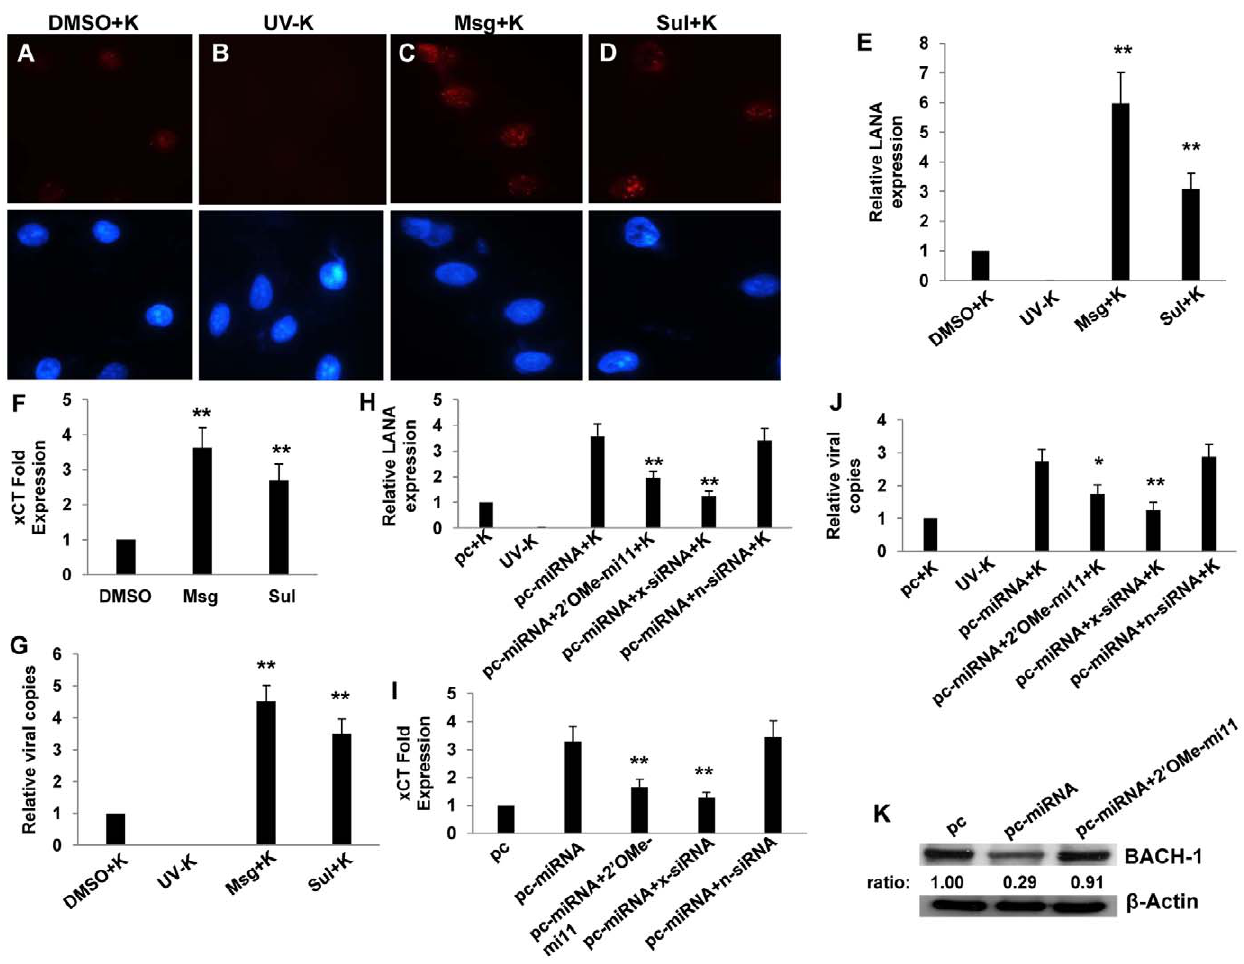
Figure 5. miR-K12-11 suppresses BACH-1 expression and increases endothelial cell susceptibility to KSHV through upregulation of xCT. ( A–G ) HUVEC were incubated with vehicle control (DMSO), Msg, or Sul for 12 h followed by purified KSHV (K) using an MOI , 0.5–1. 16 h later, LANA IFA were performed as previously described. (A–D) Representative images from one of three independent experiments are shown. ( H–K ) HUVEC were transfected with control or miRNA-expressing vectors along with a 2’OMe RNA antagomir for miR-K12-11 or either control (n) or xCT- specific siRNA. ( E , H ) Relative LANA expression was determined as described in Methods. ( F , I ) qRT-PCR was used to determine relative xCT transcript expression. ( G , J ) qPCR was used to determine relative intracellular KSHV DNA content normalized to controls. ( K ) Western blots were used to identify BACH-1 protein expression and immunoreactivity quantified as previously described. For all assays, error bars represent the S.E.M. for three independent experiments. *=p , 0.05, * *=p , 0.01 (For Fig. H–J, comparisons are relative to either pc-miRNA or pc-miRNA +